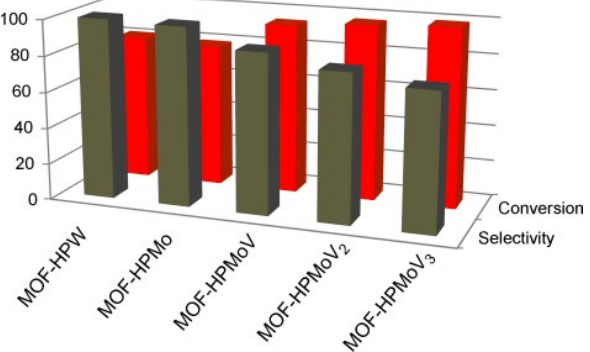
Figure 4. Oxidation of benzyl alcohol by different POM@MOF-199 catalysts. Reprinted with permission from [70]. Copyright (2014), John Wiley and Sons.